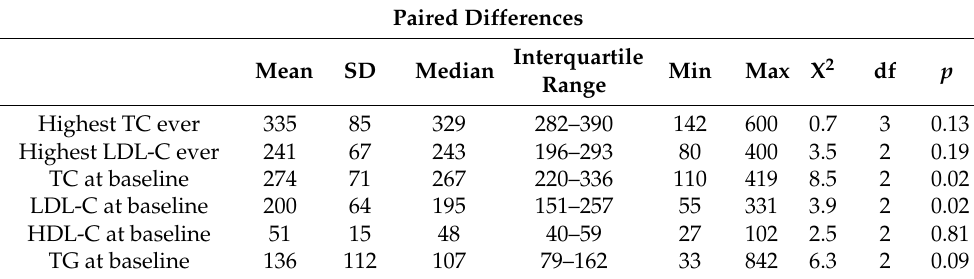
Figure 2. Baseline TC and LDL-C ever depending on the underlying gene mutation. Abbrevia- tions: LDL-C—low-density lipoprotein cholesterol, LDLR—low-density lipoprotein receptor, ApoB— apolipoprotein B, Min—minimum, Max—maximum. Table 2. An association between mutation type and lipidogram.